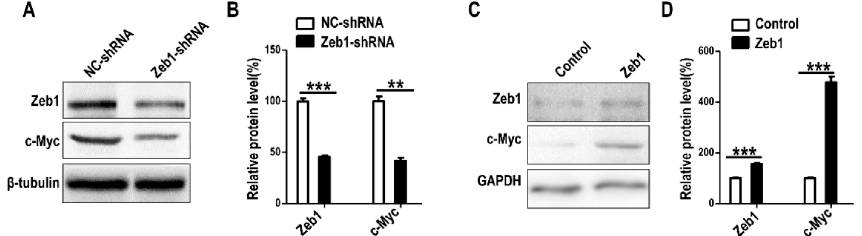
Figure 9. The expression of c-Myc in mK3 cells is regulated by Zeb1 . ( A ) Western visualization shows that mK3 cells introduced with Zeb1 -shRNA for 48 h expressed c-Myc less than cells treated with control shRNA at protein level; ( B ) The expression was calculated by scanning gray in Image J software normalized to the internal control GAPDH. The result was displayed with error bars representing mean ± SD ( n = 3). ** p < 0.01, *** p <0.001; ( C ) The protein expression of c-Myc was increased in mK3 cells treated with Zeb1 overexpression for 48 h compared with the control cells (blank vector); ( D ) The expression was quantified the same way as in ( B ).